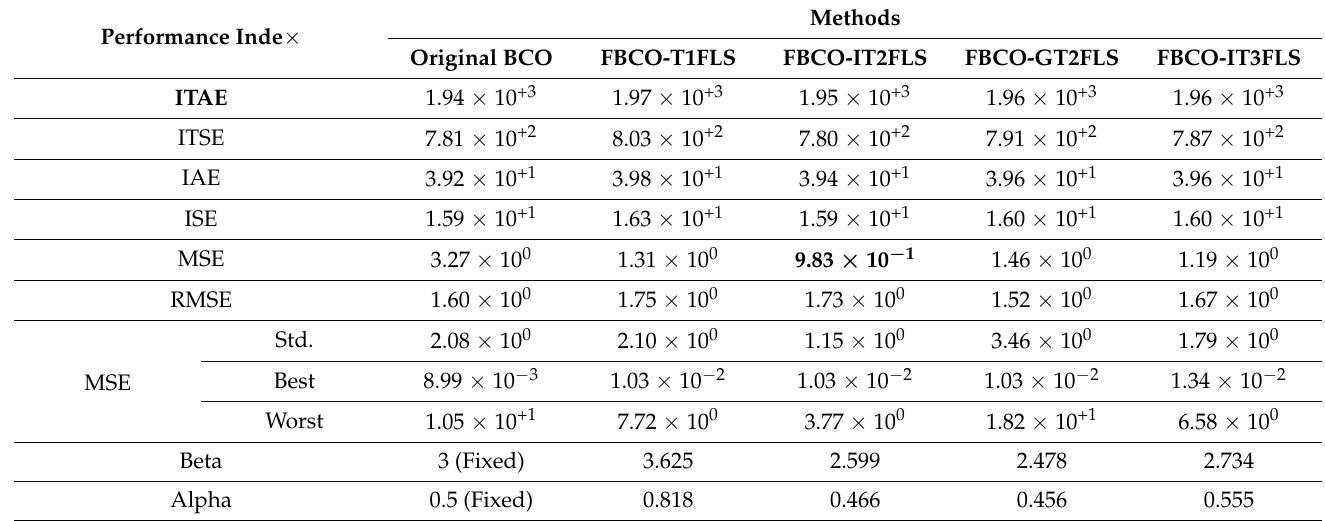
Table 1. Simulation errors for each Fuzzy BCO algorithm without disturbance in the model.